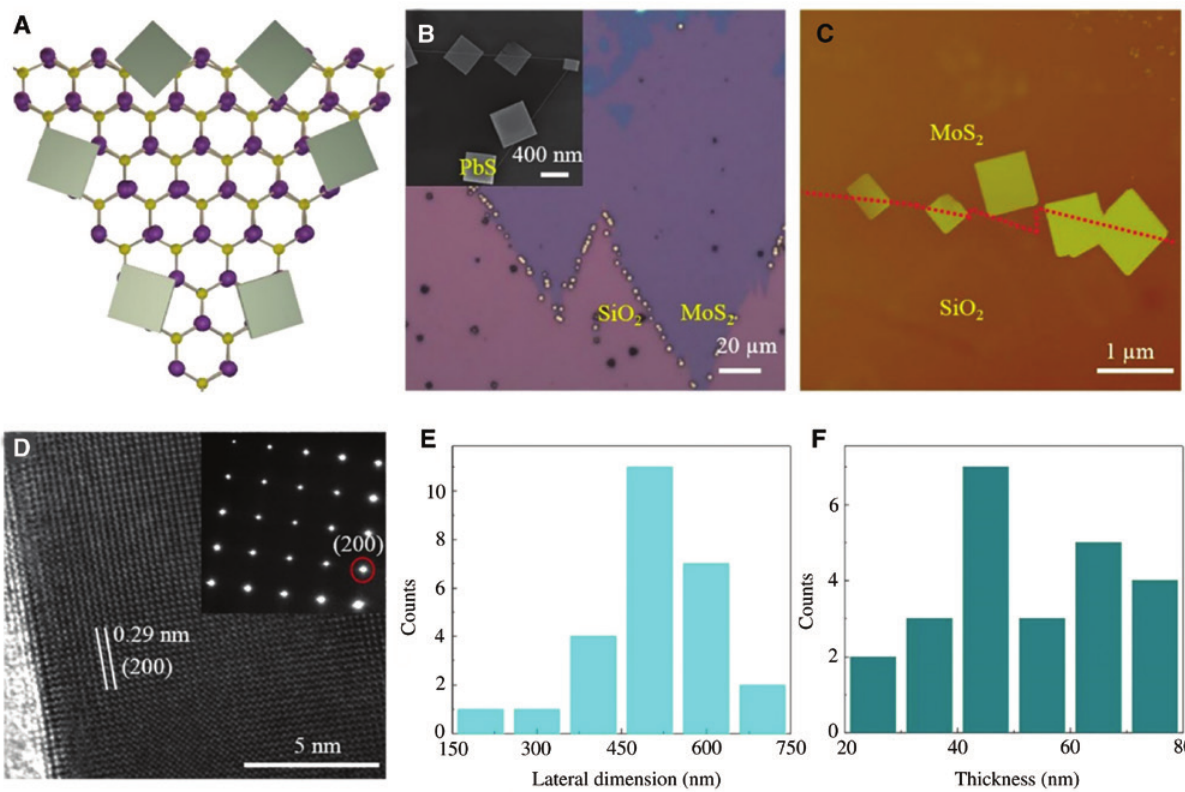
heterostructures. (A) Schematic illustration of PbS nanoplates-MoS 2 2 triangle. Inset 2 triangle. (D) HRTEM 2 . The histogram statistics of PbS nanoplates: the lateral dimension 2